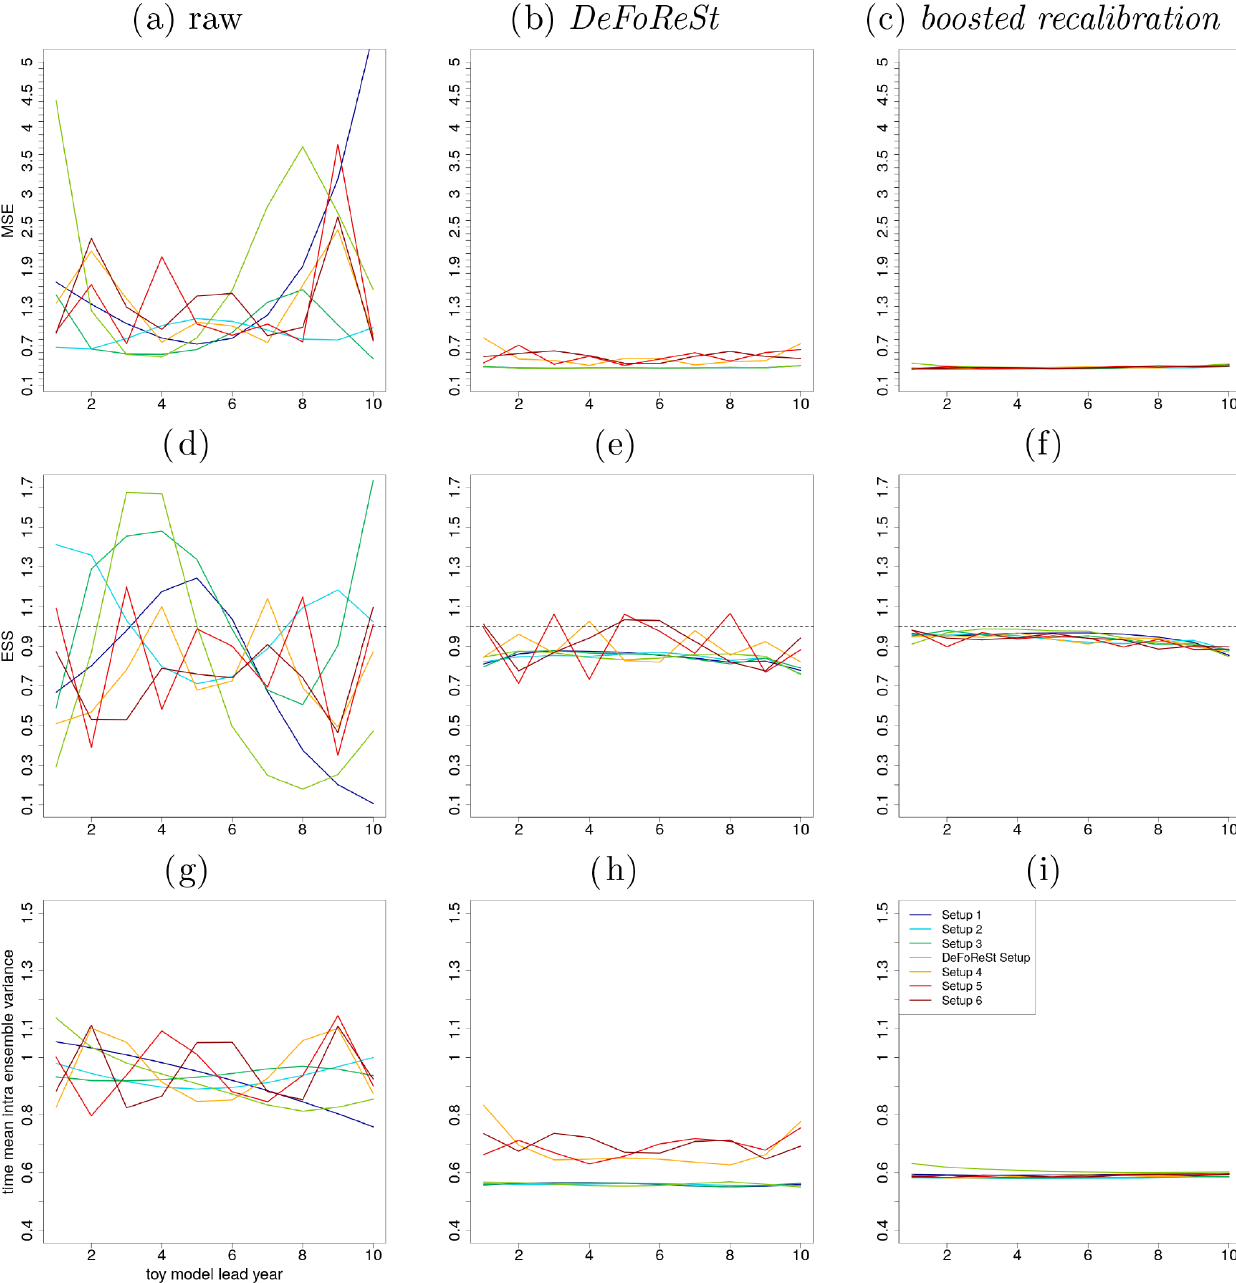
Figure 6. Mean squared error (MSE) of different toy model setups with high potential predictability ( η = 0 . 8, colored lines). (a) Raw pseudo- forecast, (b) post-processing with DeFoReSt and (c) post-processing with boosted recalibration. Panels (d) to (f) show the ESS and (g) to (i) the intra-ensemble variance (temporal average),